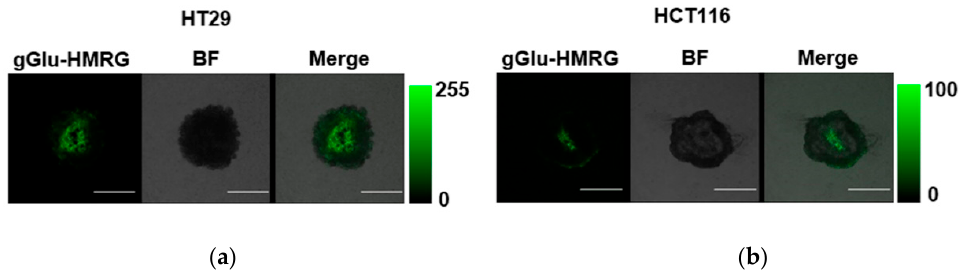
Figure 5. Fluorescence imaging of gGlu-HMRG : in HT29 ( a ) and HCT116 ( b ) tumor spheroids. Adapted with permission from [118]. Scale bars = 500 µm.